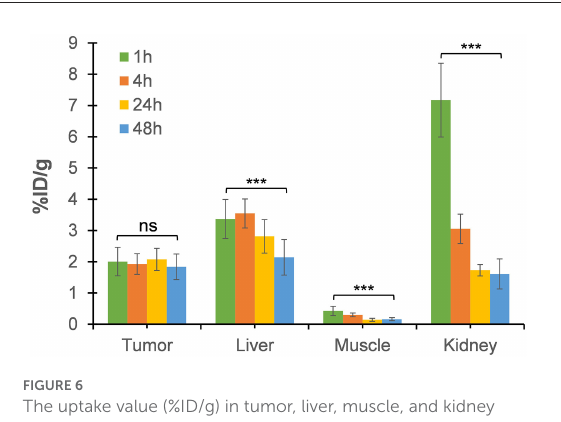
FIGURE6 The uptake value (%ID/g) in tumor, liver, muscle, and kidney derived from static PET images at 4, 24, and 48h post-injection relative to that of 1-h dynamic scan. Each data point represents the averages ± SD for 7 HCT116 tumor-bearing nude mice (***p value < 0.001; ns, not